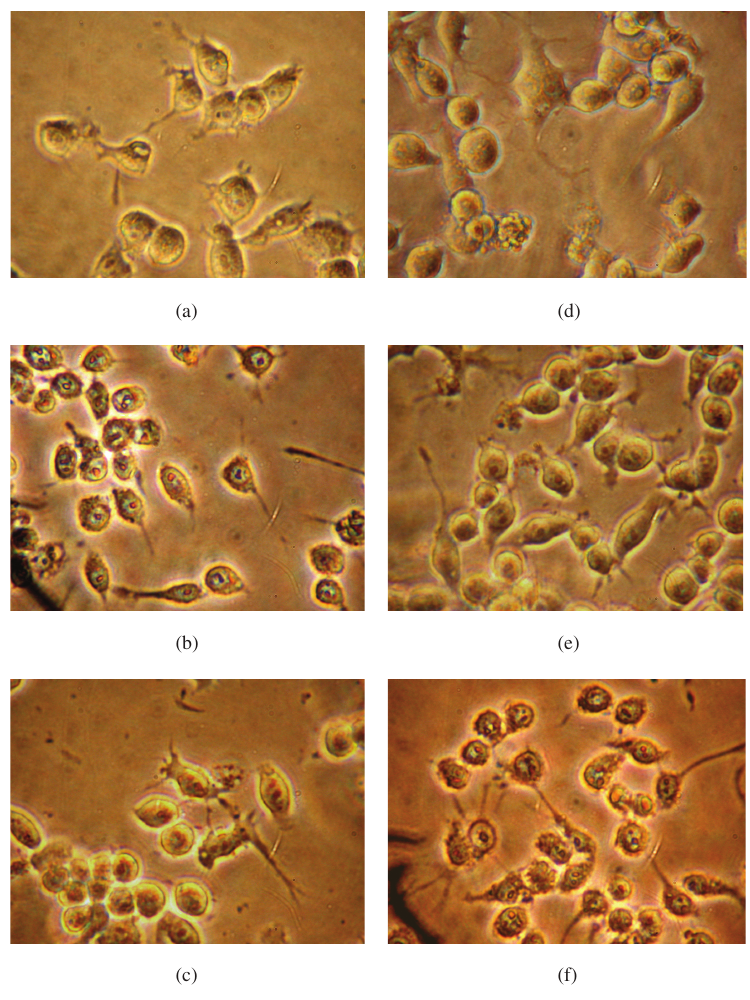
FIGURE 4: Nitrotyrosine formation in (a) RAW 264.7 cells, (b) RAW 264.7 cells stimulated with LPS, (c) LPS-stimulated RAW 264.7 cells treated with L-NAME (25 μ M), (d) iNOS − / − RAW 264.7 cells, (e) iNOS − / − RAW 264.7 cells stimulated with LPS, and (f) RAW 264.7 cells transfected with negative control plasmid stimulated with LPS. Cells were incubated in the presence of DMEM media supplemented with 400 μ M of